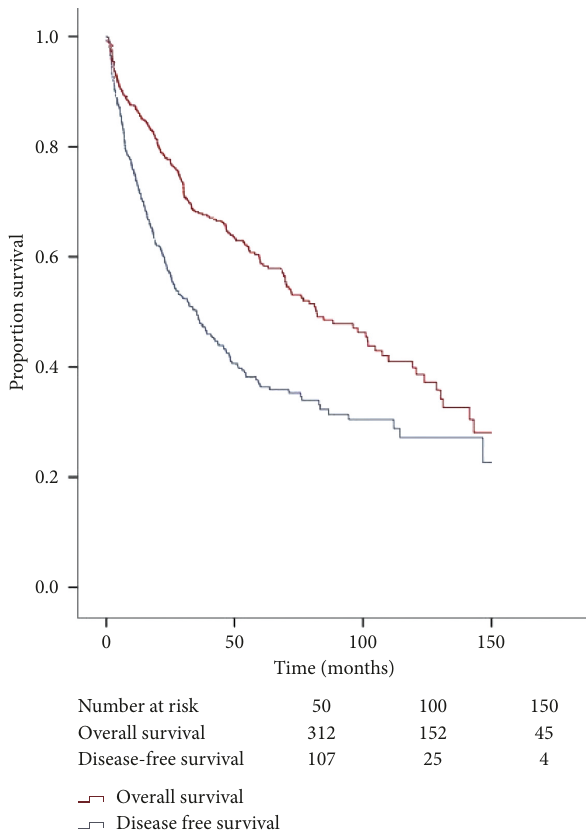
Figure 2: Kaplan–Meier curves for disease-free and overall survival demonstrating median survival of 35.3 months (95% CI: 27.6–43.0) and a 1-, 5-, and 10-year overall survival of 86.2%, 64.3%, and 58.7%, respectively, with associated number at risk for each time